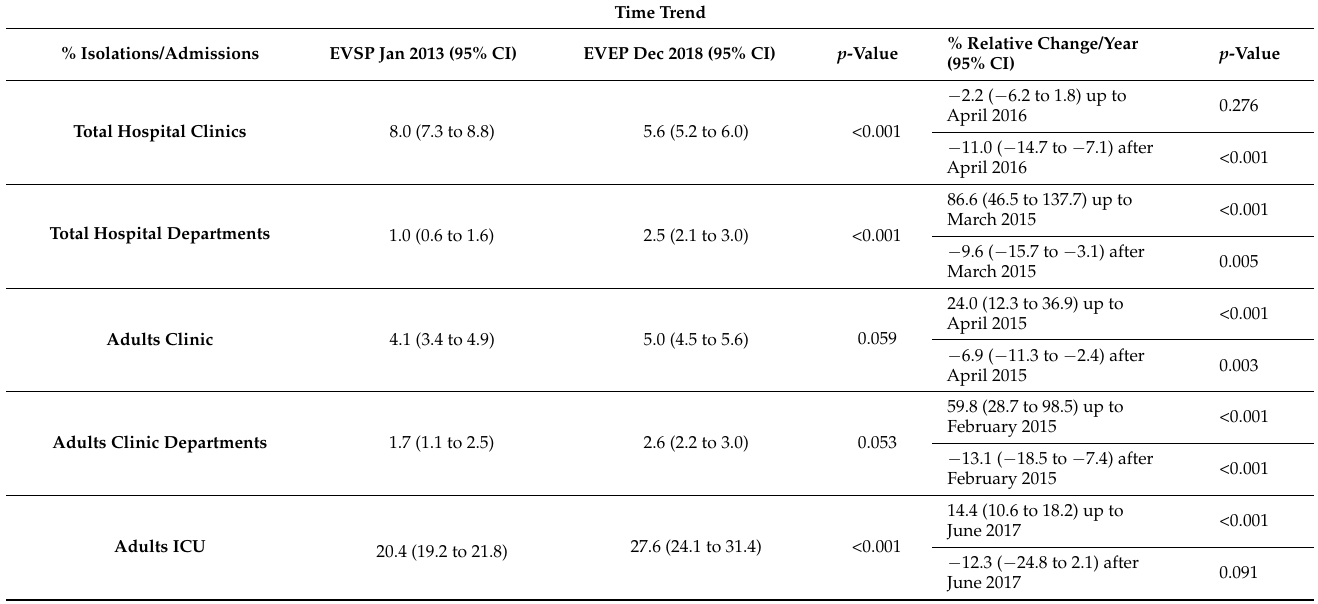
Table 2. Time trend of isolations/100 hospital admissions in a hospital from January 2013 to December